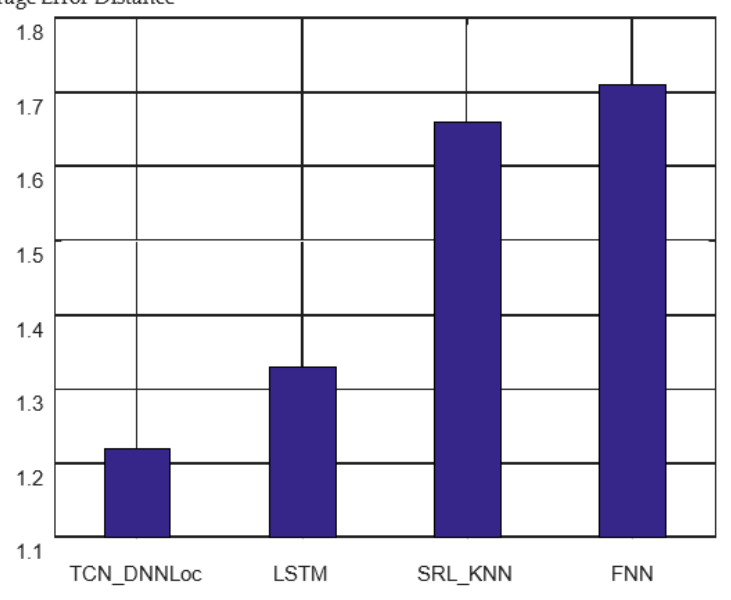
Figure 13. 3D positioning error of different models.